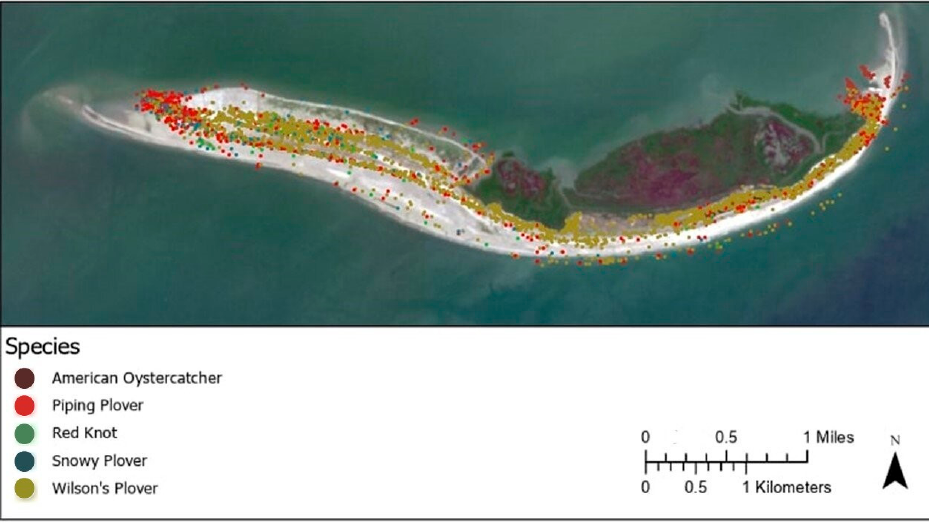
Figure 1. Whiskey Island, Louisiana, and locations of migratory bird observations.